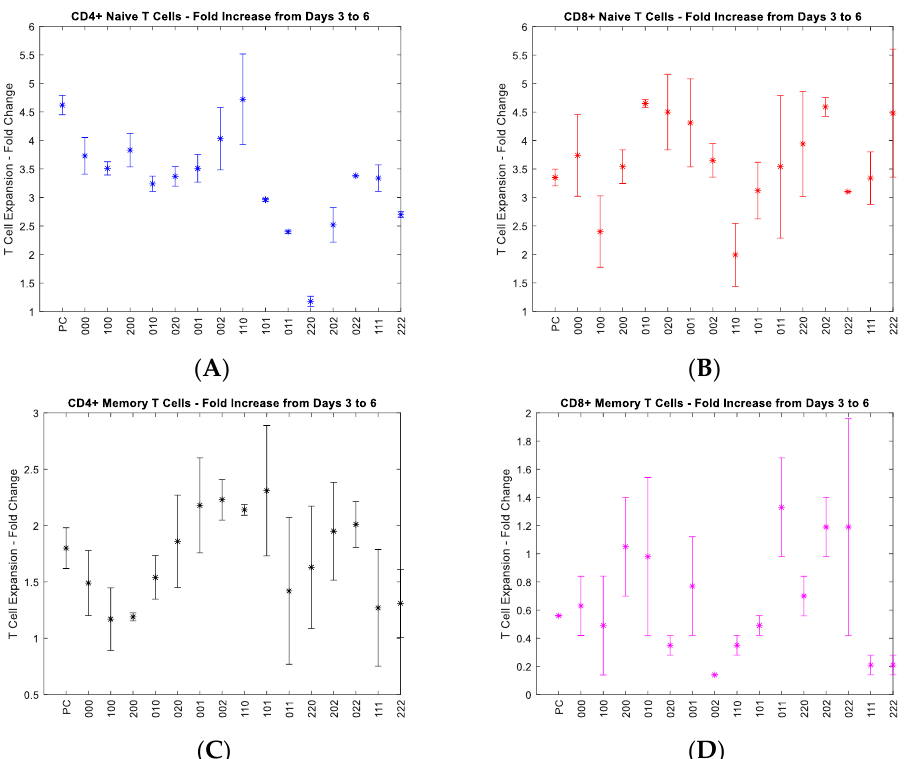
Figure 1. Average ( n = 3) fold-change plots for all T cell subsets and corresponding conditions: ( A ) naïve CD 4+ T cells, ( B ) naïve CD 8+ T cells, ( C ) memory CD 4+ T cells, ( D ) memory CD 8+ T cells. The X-axis represents each experimental condition. For example Index 0, 1, and 2 represents the minimum (low), the medium (middle) and maximum (high) level for each cytokine as shown in Table 1, with 0 standing for 10 ng/mL (IL-2), 1.5 ng/mL (IL-7), and 10 ng/mL (IL-15); 1 standing for 33 ng/mL (IL-2), 36 ng/mL (IL-7), 36 ng/mL (IL-15); 2 standing for 60 ng/mL (IL-2), 80 ng/mL (IL-7), and 80 ng/mL (IL-15). The “no cytokines” condition in Table 1 is denoted here by “PC” for the control condition. For example, “010” would represent low IL-2 concentration, moderate IL-7 con-centration, and low IL-15 concentration. These concentrations were selected on the basis of our previous work [14] and literature review.